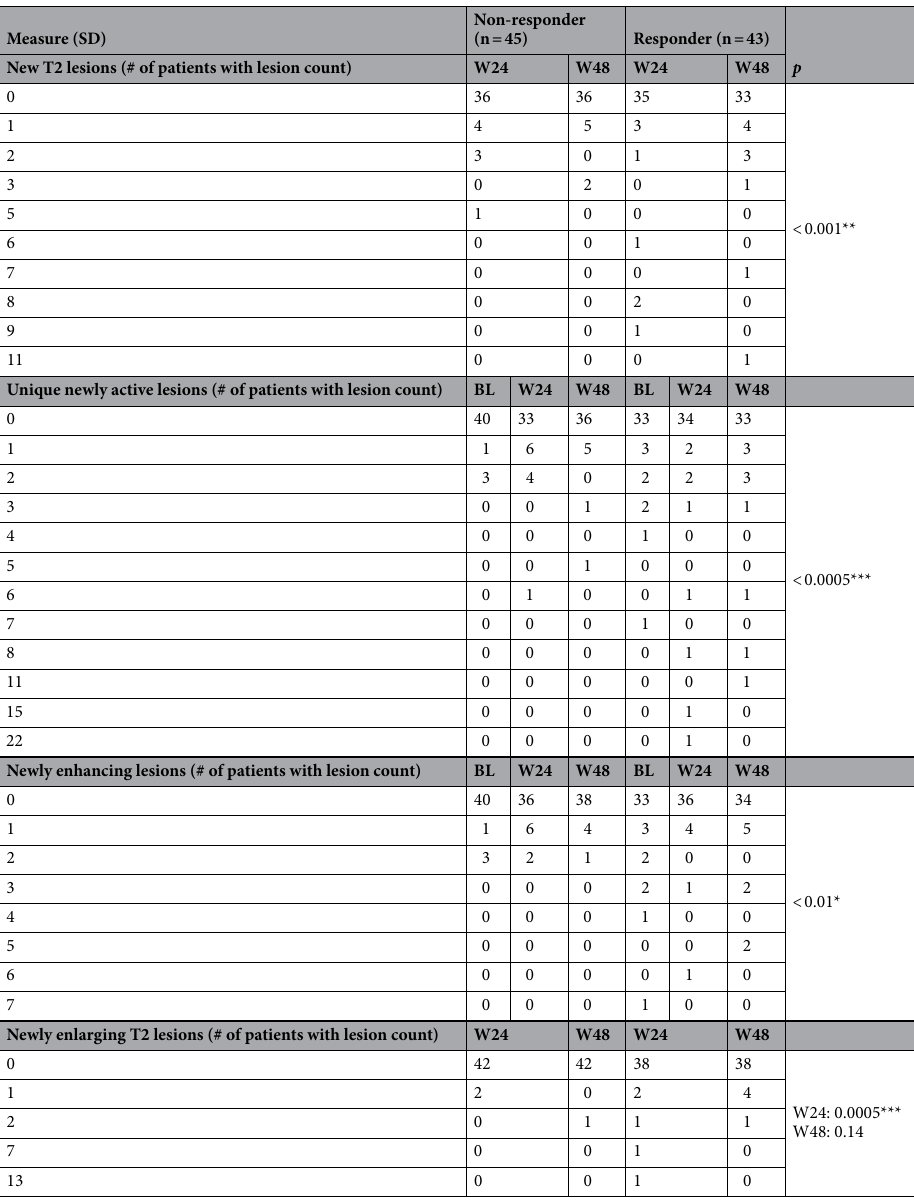
Table 4. Brain morphometric characteristics and lesions. BL = Baseline; W24 = 24 weeks assessment point; W48 = 48 weeks assessment point; WM = white mater. P values represent comparisons between